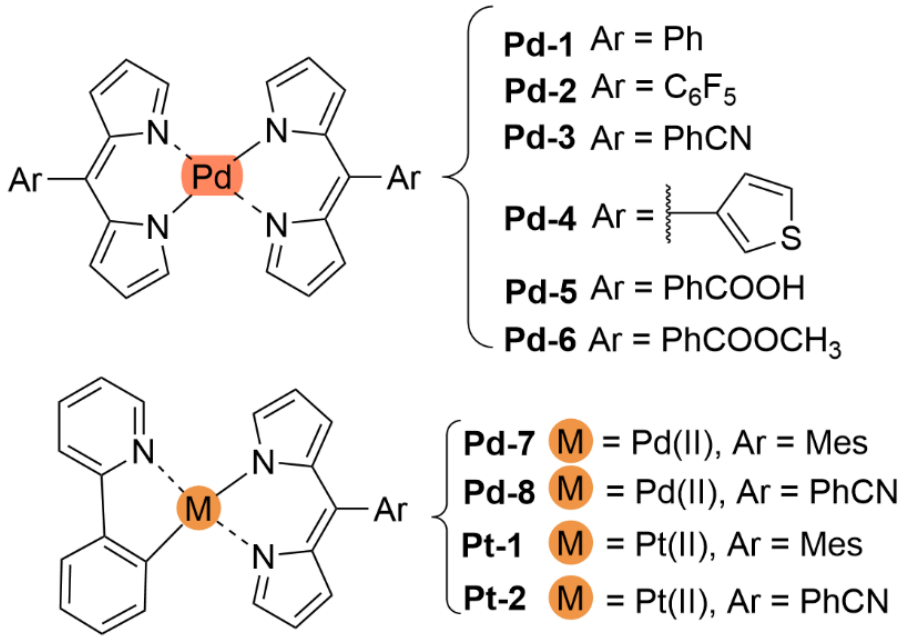
Figure 21. Chemical structures of (dipyrrinato)Pd(II) and -Pt(II) complexes. Hall et al. showed that Pd-6 maintained a strictly square planar configuration (Figure 22) [67]. The strain caused by the inter-ligand contacts of the α -protons was accommodated by forcing the ligands to cant away from the PdN 4 plane, causing the two dipyrrinato ligands to lose coplanarity. Additionally, a nonplanar distortion of the bis- pyrrolic core was observed to further accommodate strain. Pd-5 and Pd-6 displayed intense bands in their UV-Vis spectra around 480 nm, which were ascribed to 1 π - π * transitions of the dipyrrinato moieties (Figure 13). Hall et al. noted that this showed that the curvature found in the dipyrrinato ligands did not significantly perturb their electronic transitions. Exciton coupling was not visible in their absorption spectra due to a null net transition dipole moment for the transition to the lower energy excited state [68–70]. The dipyrrinato 1 π - π * transitions were found to be non-emissive upon irradiation. Recently, Mathew et al. reported the synthesis of Pd-(1–4) via a one-pot reaction and a preliminary investigation on their antitumor activity [178]. For these complexes a loss of coplanarity between the dipyrrinato ligands (similar to Pd-6 ) and a curvature of the bis-pyrrolic core were observed. Additionally, the complexes were shown to adopt a slightly additional distorted square planar geometry. Some experimental results are shown in Table A3 (Appendix A). The absorption spectra of these complexes displayed one intense band for π − π * transitions around 470–490 nm ( ε = 55,000 M − 1 cm − 1 ). Additionally, a broad band around 350–400 nm ( ε = 10,000 M − 1 cm − 1 ) was observed, corresponding to a MLCT transition. These complexes displayed both weak luminescence and fluorescence ( ϕ f = 0.008–0.031 in acetonitrile, chlo- roform, and toluene). Their weak fluorescence is supported by short singlet state lifetimes (2.5–3.8 ns). Triplet state lifetimes were obtained with transient absorption spectroscopy for Pd-(1–4) (45 ns, 29 ns, 32 ns, and 68 ns, respectively). The average singlet oxygen quantum yield in all the solvents was relatively low ( ϕ ∆ ≈ 0.08), with a highest value of ϕ ∆ = 0.170 found for the phenyl derivative Pd-1 in acetonitrile. Additionally, their triplet excited state lifetimes were also observed to be short (30–70 ns). It was suggested that the out-of-plane distortion of the Pd(II) complexes leads to low-lying, metal-centered (MC) d-d excited states which provide efficient non-radiative deactivation